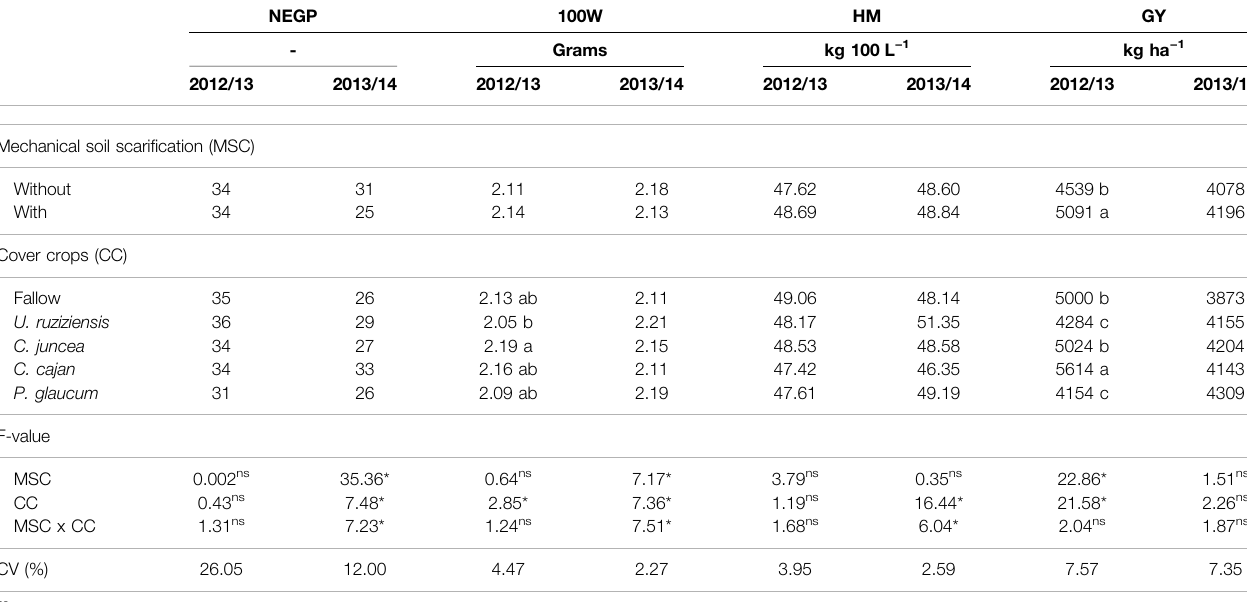
TABLE 2 | Number of empty grains per panicle (NEGP), 100-grain weight (100W), hectoliter mass (HM) and grain yield (GY) of upland rice after mechanical soil scari fi cation and cover crops cultivation in 2012/2013 and 2013/2014.